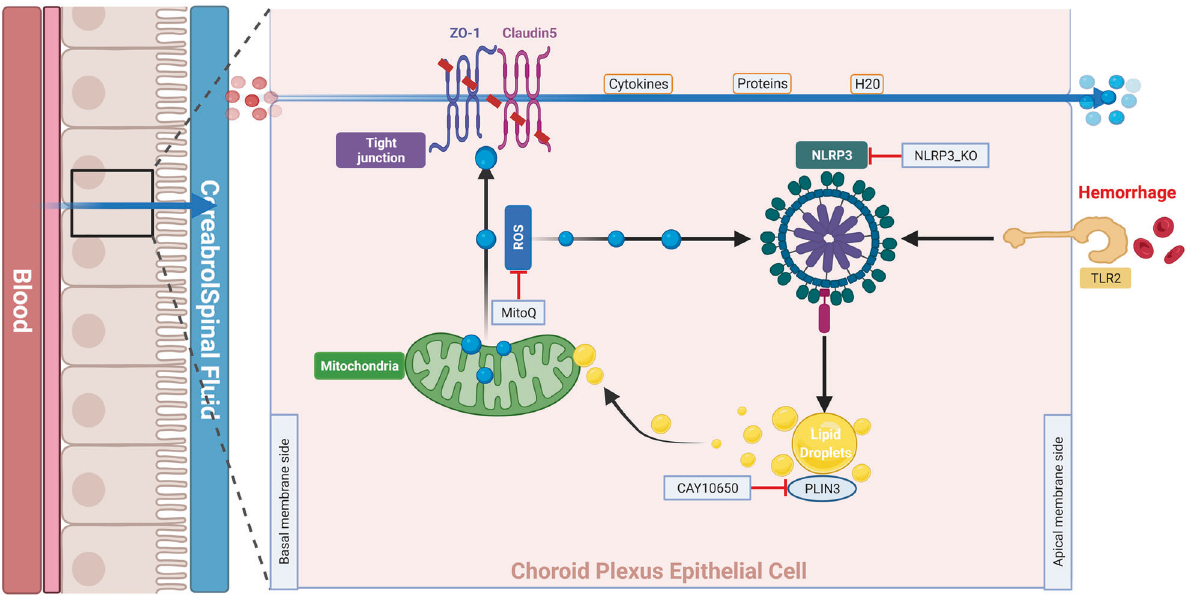
Fig. 8 Schematic representation of the mechanism. After ICH-IVH, NLRP3 was activated in the choroid plexus by TLR2. Next, NLRP3- mediated LD formation, and LDs combined with mitochondria to in fl uence their function and mitochondrial ROS production. Mitochondrial ROS destroyed the B-CSFB through